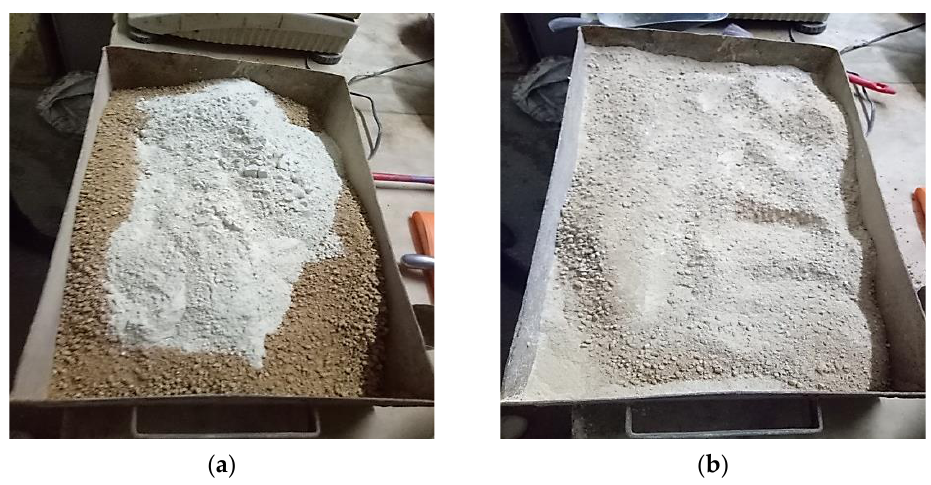
Figure 5. Preparation of soil – bentonite mixture: ( a ) soil – bentonite, ( b ) bentonite.